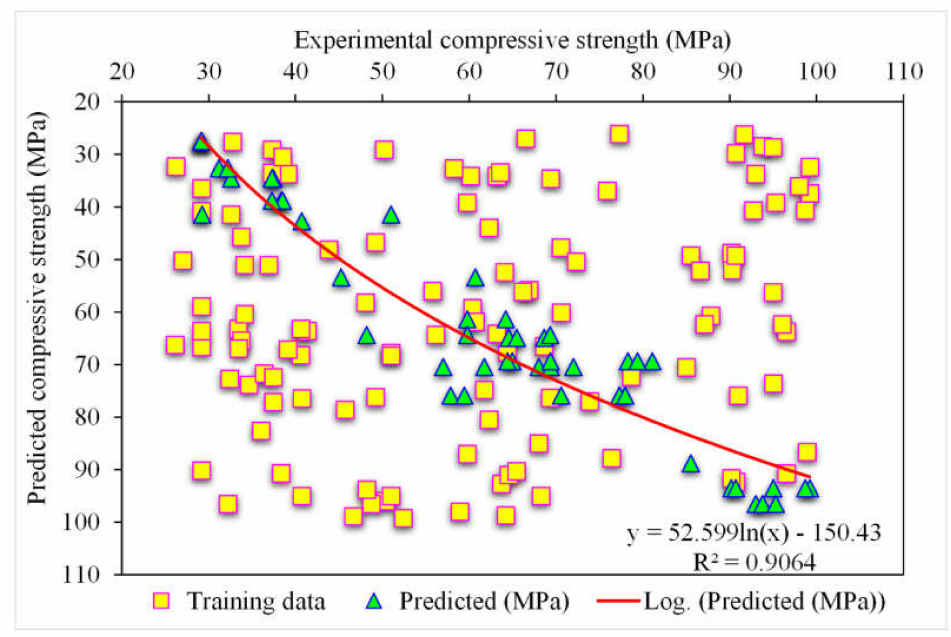
Figure 7. Experimental and XGBoost predicted